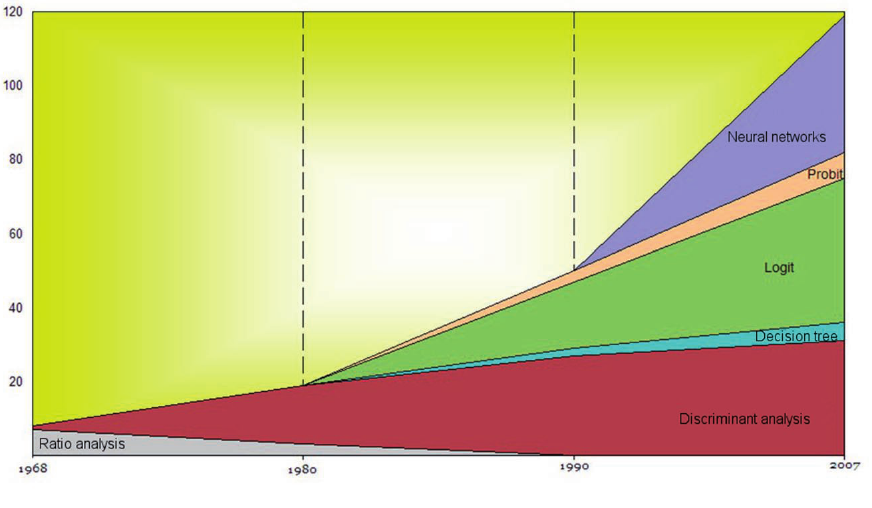
Fig. 1 – History of the bankruptcy models. Source: Imre